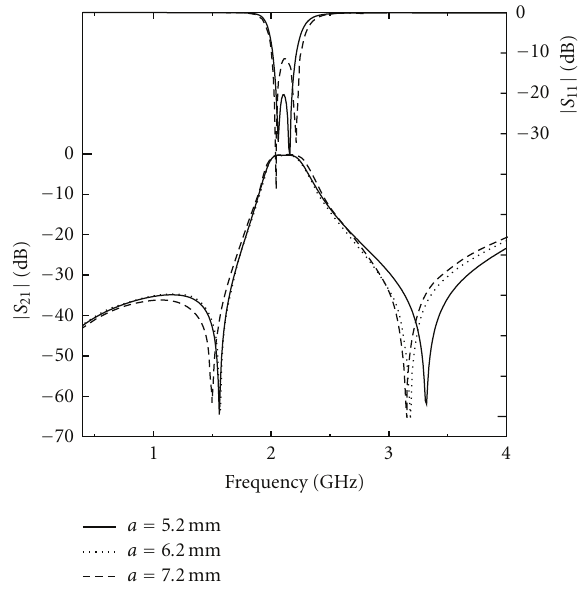
Figure 9: Frequency characteristics of scattering parameters ( d =